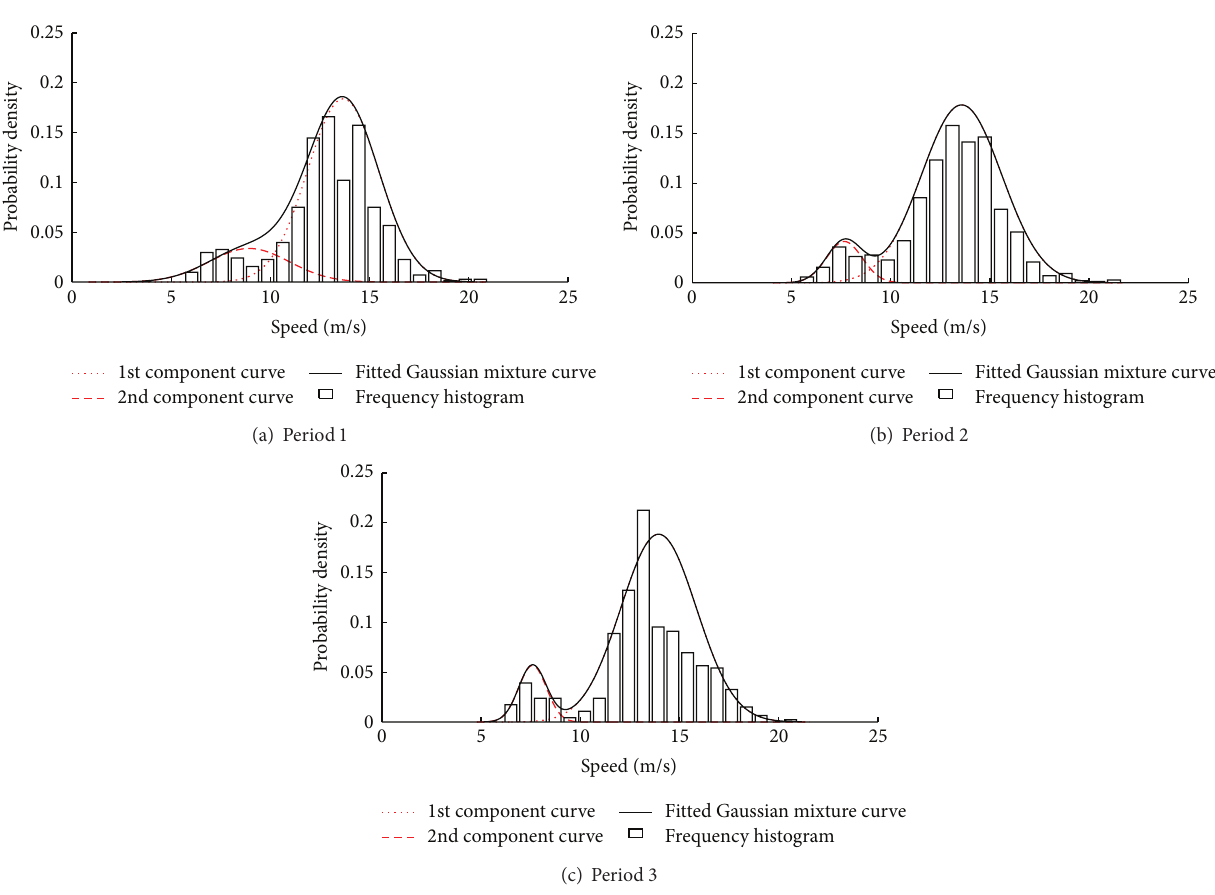
Figure 2: Speed distribution histogram and fitted Gaussian mixture distribution curve of the study segment.